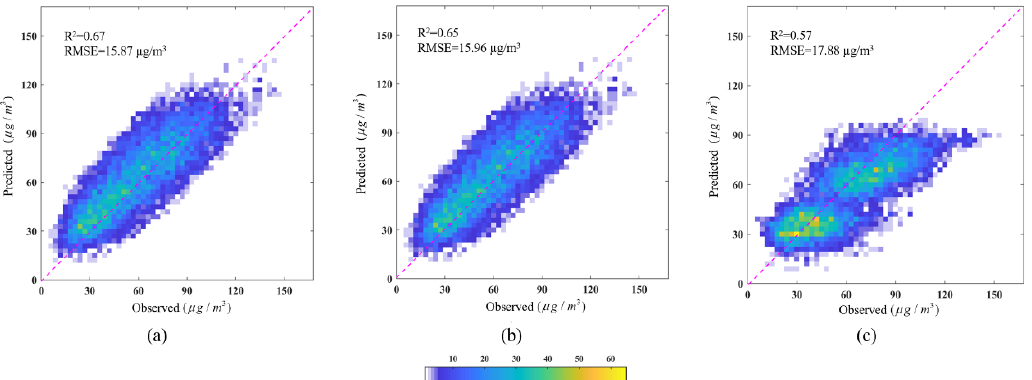
Figure 6. Density scatter plots of measurements and predictions for ( a ) hybrid model, ( b ) BME model, and ( c ) GLM (color bar represents the frequency of points).